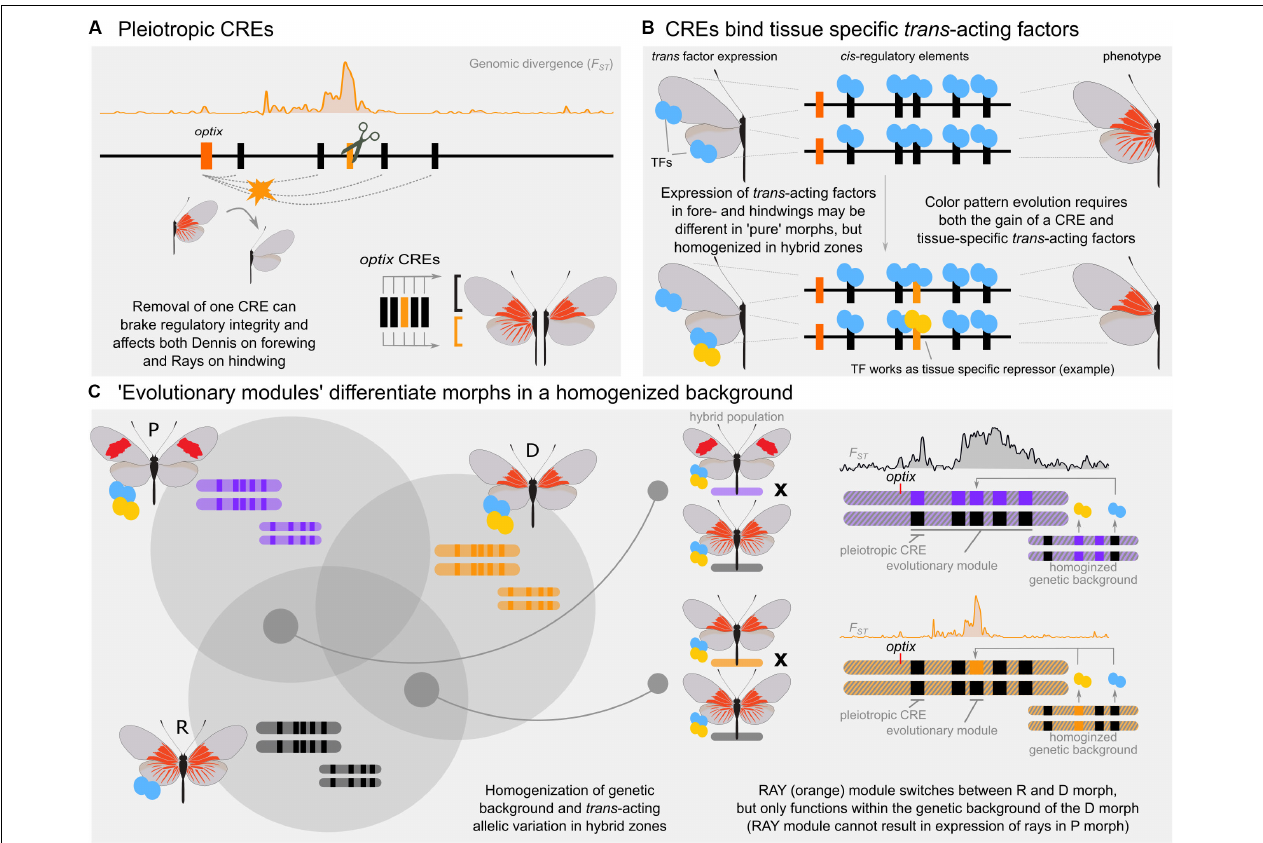
FIGURE 2 | Conceptual overview of evolutionary modularity. (A) CRISPR/Cas9 experiments of five putative CREs demonstrate that red wing patterns in Heliconius erato are controlled by an interdependent set of enhancers. Loss of any enhancer causes loss of red pattern phenotype in both fore- and hindwings and are pleiotropic (Lewis et al., 2019). (B) Hypothetical mechanism by which a novel, tissue specific phenotype (dennis) might evolve through the acquisition of both a CRE and a tissue-specific transcription factor. Blue and yellow symbols indicate tissue specific transcription factors (TFs) which may be unique to a “pure” population but homogenized in hybrid zones. The evolutionary module in this example includes a CRE that is accessible to TFs in both the fore- and hindwing, but may bind a TF unique to the hindwing in the dennis morph only. (C) Depiction of hypothesized evolutionary modularity in the East Amazon H. erato hybrid zone. Multiple unlinked alleles control divergence between all three morphs (Left). These loci become homogenized in narrow regions of hybridization, allowing a single locus to modulate wing pattern phenotype (Right). These homogenized loci can include trans -acting factors, which may not show any signal of differentiation in genomic hybrid zone